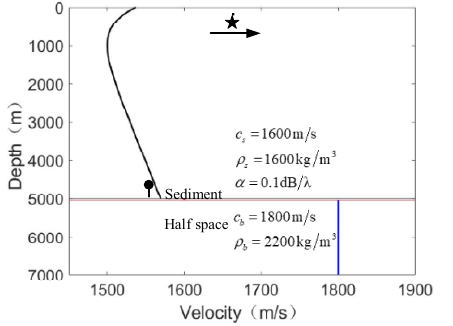
Figure 1. Deep water environment with Munk sound speed profile.